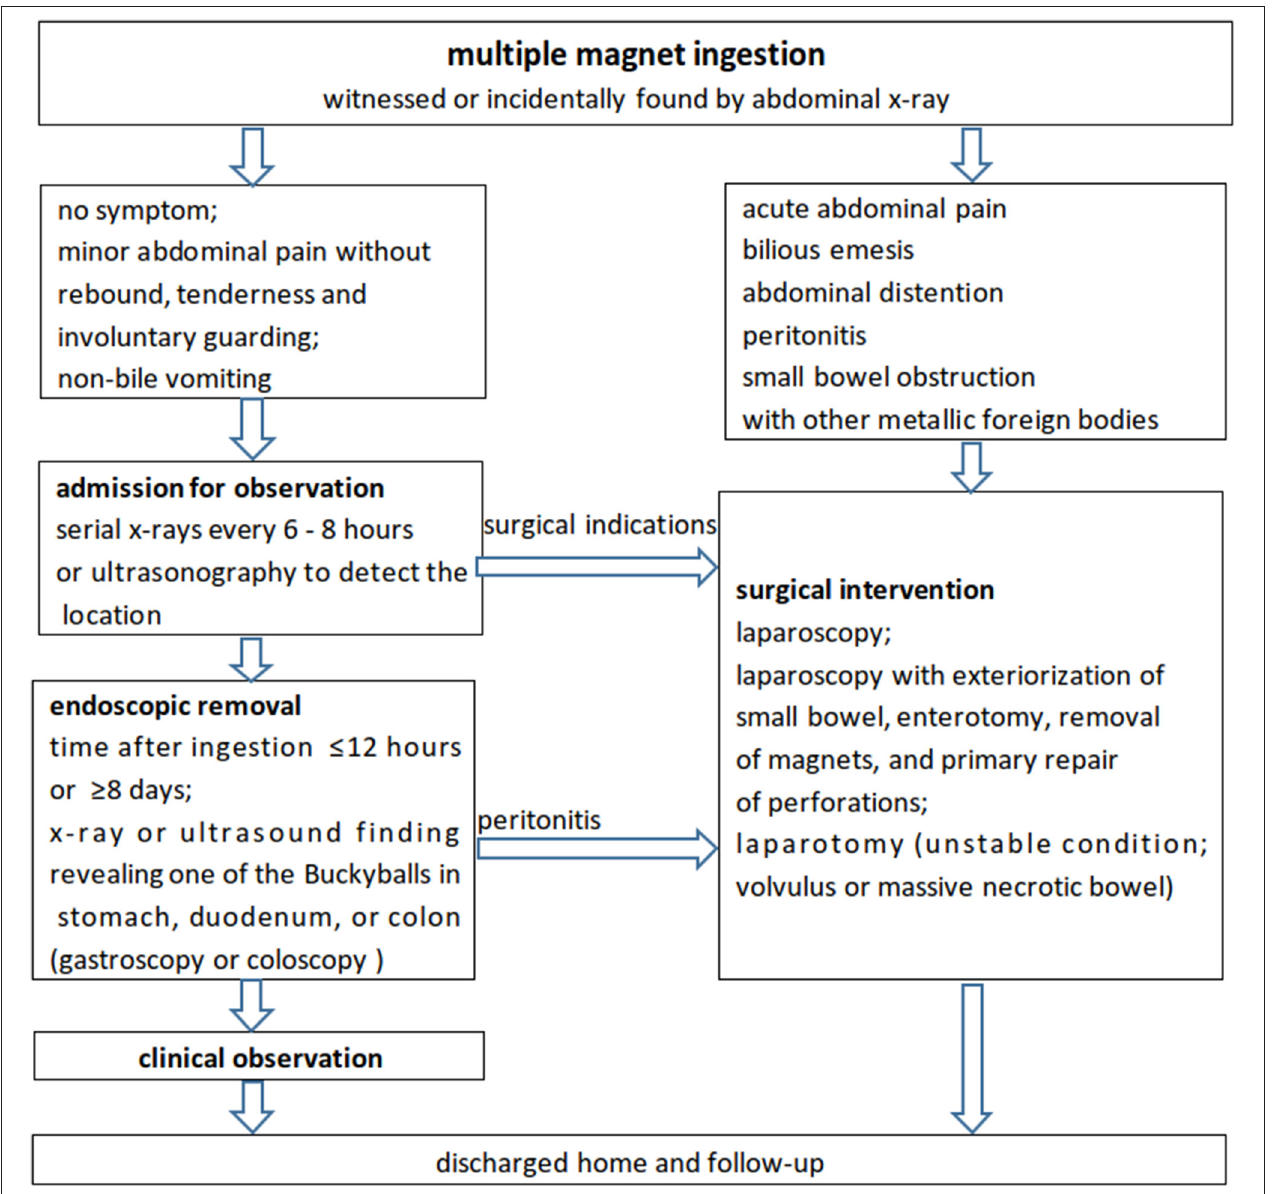
FIGURE 3 | A recommended flowchart for the management of multiple high-powered magnet ingestions in the pediatric population according to the literature and our experience.